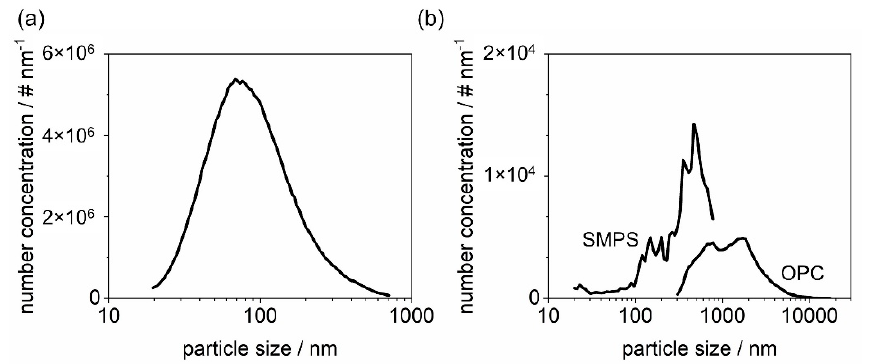
Figure 3. Particle size distribution of K 2 SO 4 measured with an SMPS ( a ) and glass spheres measured with SMPS and OPC ( b ).